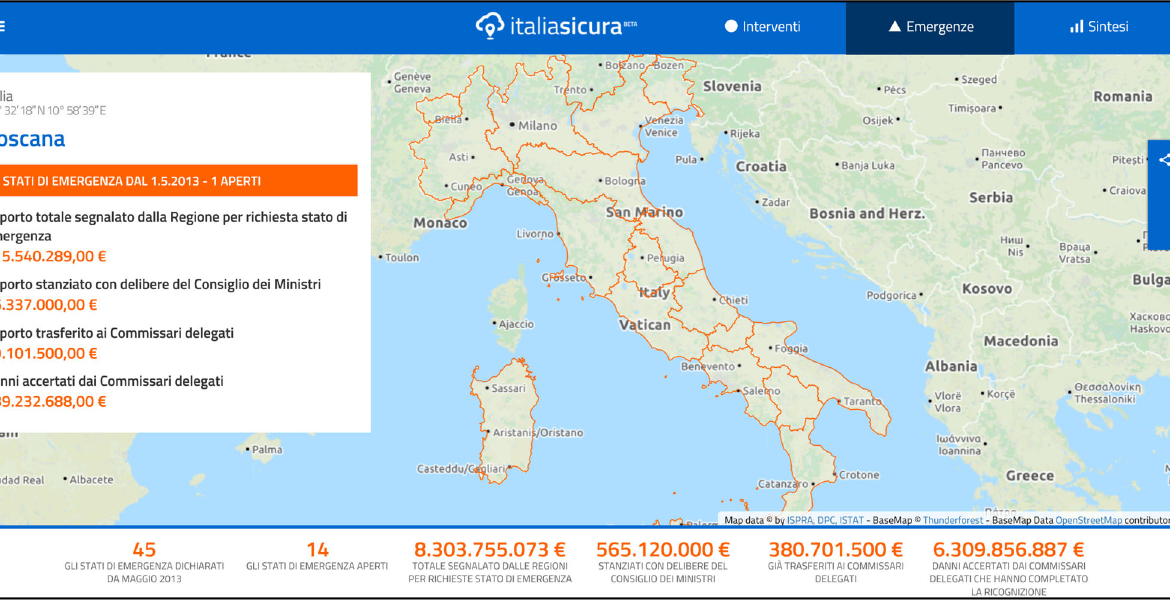
Fig. 3 Screenshot of the second page of the #italiasicura platform, showing data on